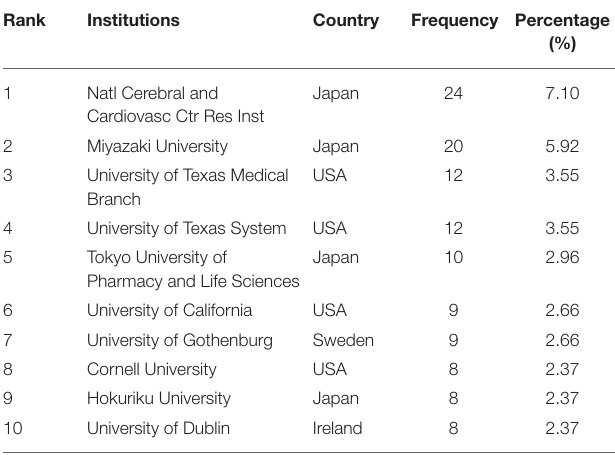
TABLE 3 | The list of top 10 Institutions contributed to the publications on NMU researches from 1987 to 2021.